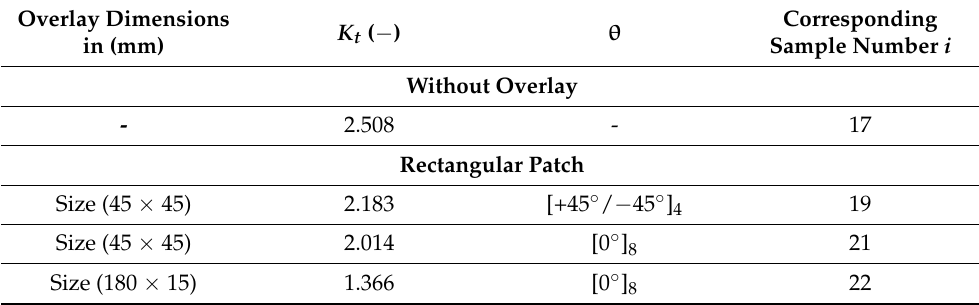
Table 5. Stress concentration factor at notch in adherend, θ —fibre angle orientation in layers with respect to tension